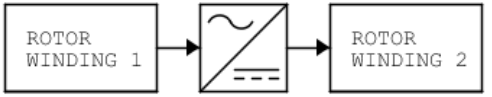
Figure 1. Schematic representation of the rotor windings in the Self-Excited Synchronous Machine.